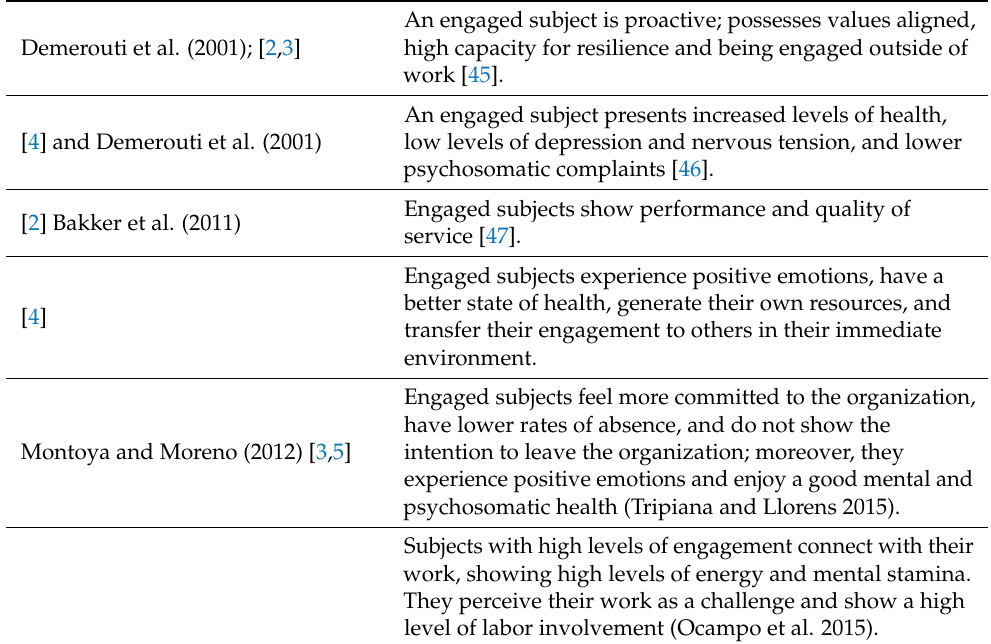
Table 2. The benefits of